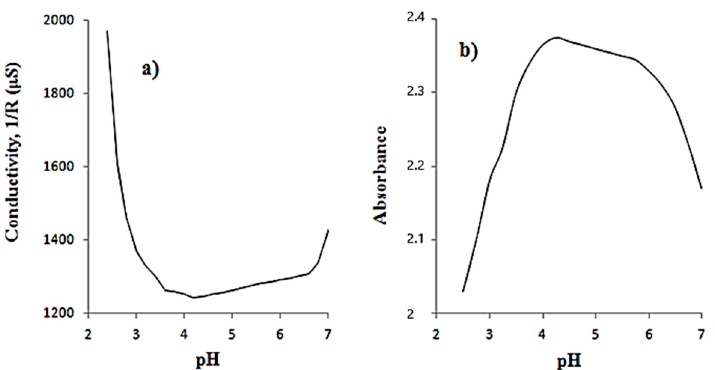
performed at 800 nm for Ni 2+ and Cu 2+ and at 870 nm for Fe 3+ , respectively, and at 1100 nm for Mn 2+ and Co 2+ .